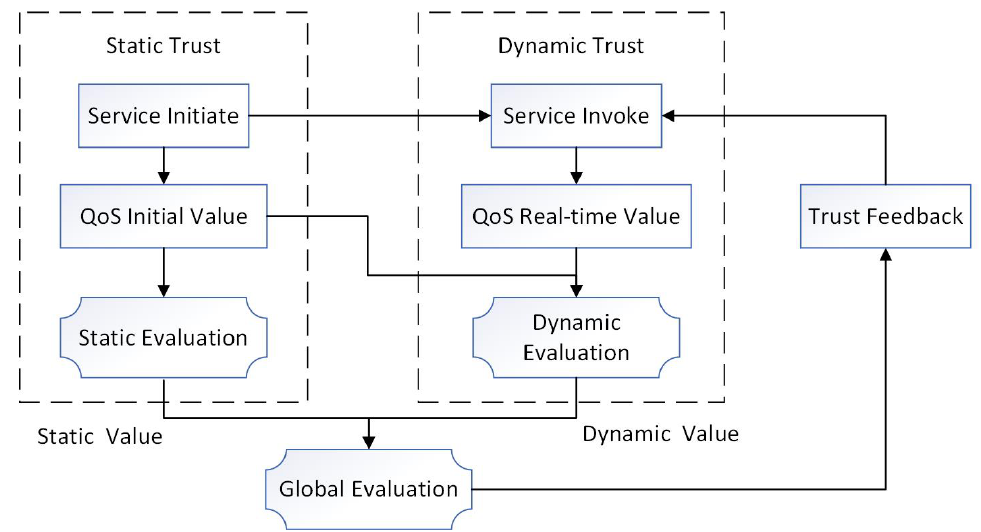
Figure 2. The overall framework of the service trust evaluation